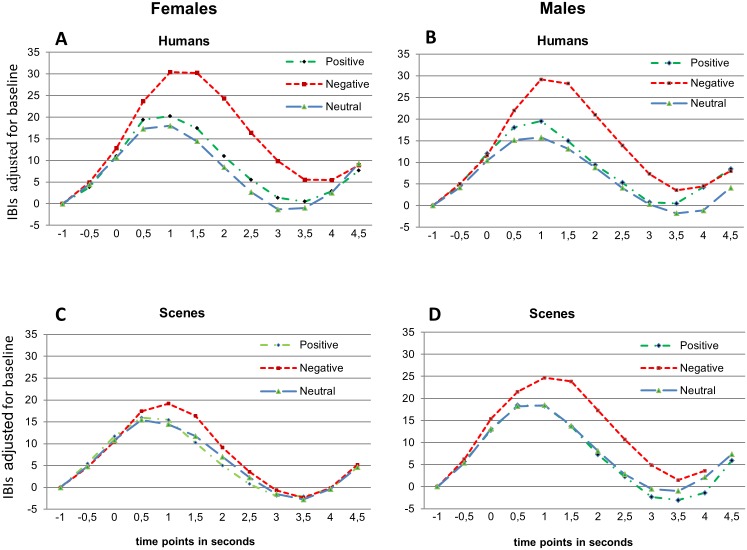
Baseline-adjusted IBIs in response to the IAPS pictures (t = 0 s) separated per sex.Upper panel: humans present in the pictures; lower panel humans absent.